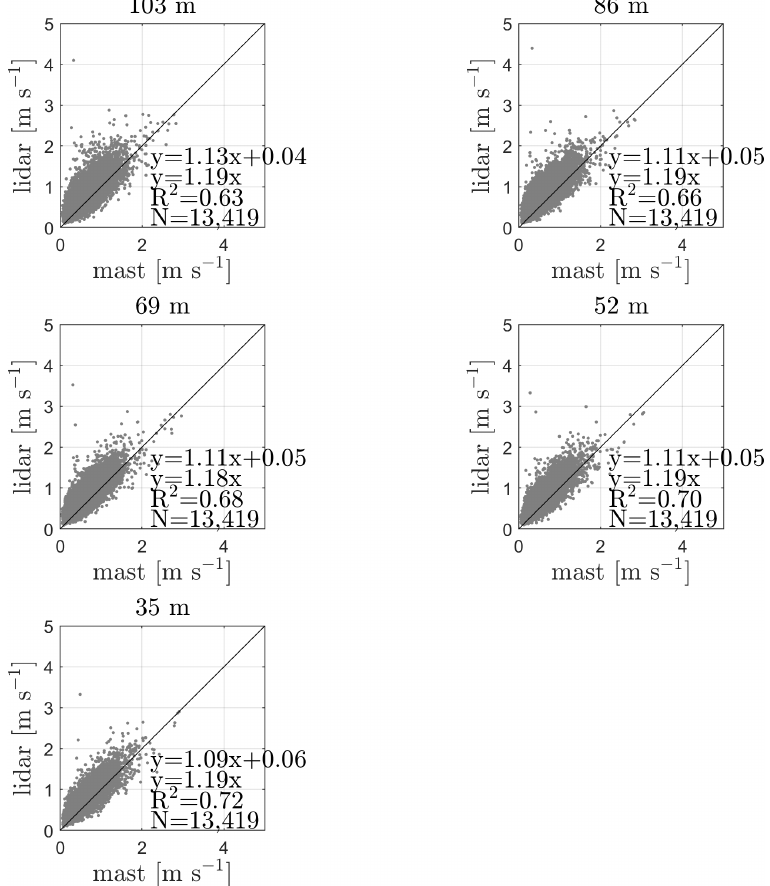
Figure 8. Similar to Figure 7 but for the standard deviation of the wind speed.